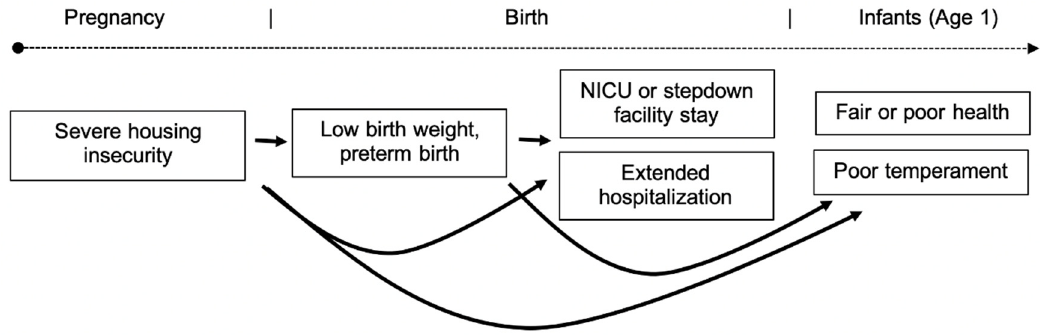
Figure 1. Framework illustrating hypothesized associations between severe housing insecurity (threated eviction or homelessness) during pregnancy, birth outcomes, and infant health and potential pathways linking the exposure and outcomes.